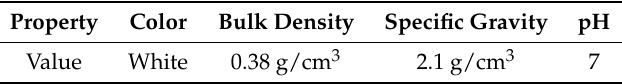
Table 4. Properties of diatomite.